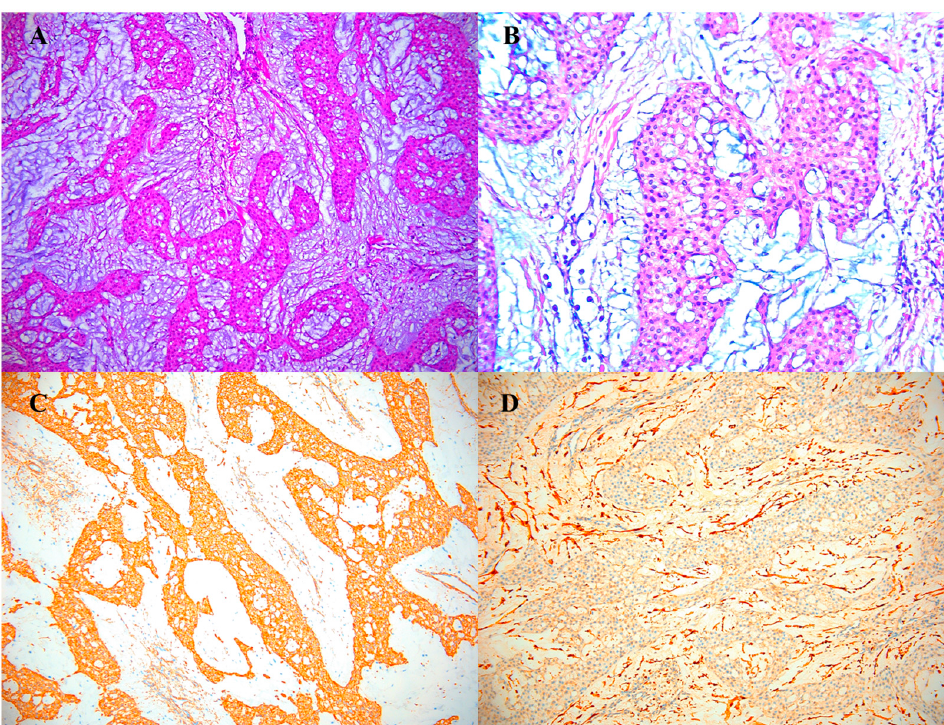
Figure 5. Glomus tumor. ( A , B ) Hematoxylin–Eosin (HE) glomic cells are small, uniform, often round, with a small, round nucleus placed centrally in the cell, the chromatin is homogeneous and the nucleoli are barely visible. The cytoplasm is amphophilic or pale eosinophilic. ( A ) HE × 2; ( B ) HE × 10; ( C ) positive marking for SMA; ( D ) negative marking for S100 positive.